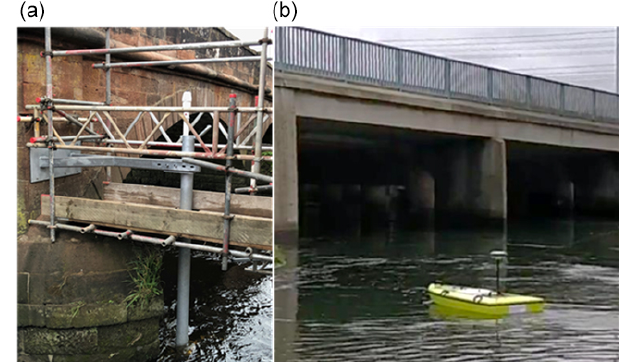
Figure 4. (a) Probe for continuous monitoring of total scour at a pier of the A76 200 bridge over the river Nith in New Cum- nock (Maroni et al., 2020a). (b) Surveying remote-controlled boat equipped with sonar, acoustic Doppler velocity profilers, RTK (real- time kinematic) GPS, and other motion sensors (developed at the University of